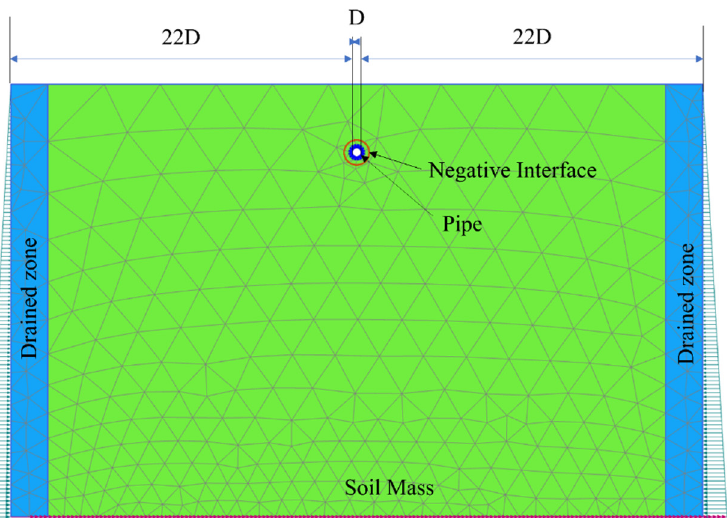
Figure 2. A typical discretized soil volume with two drained zones on the two